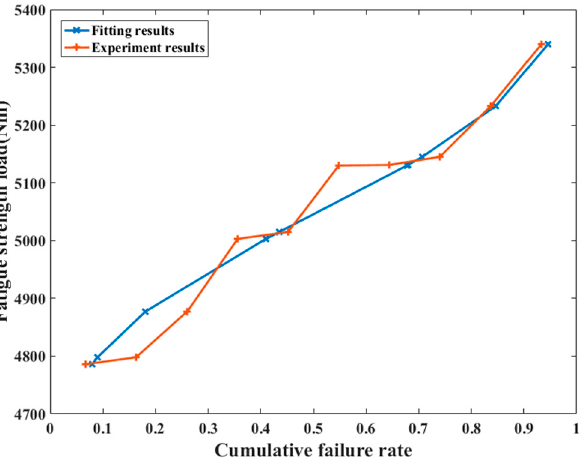
Figure 15. The fitting results of the fatigue limit load based on the Gaussian distribution function.